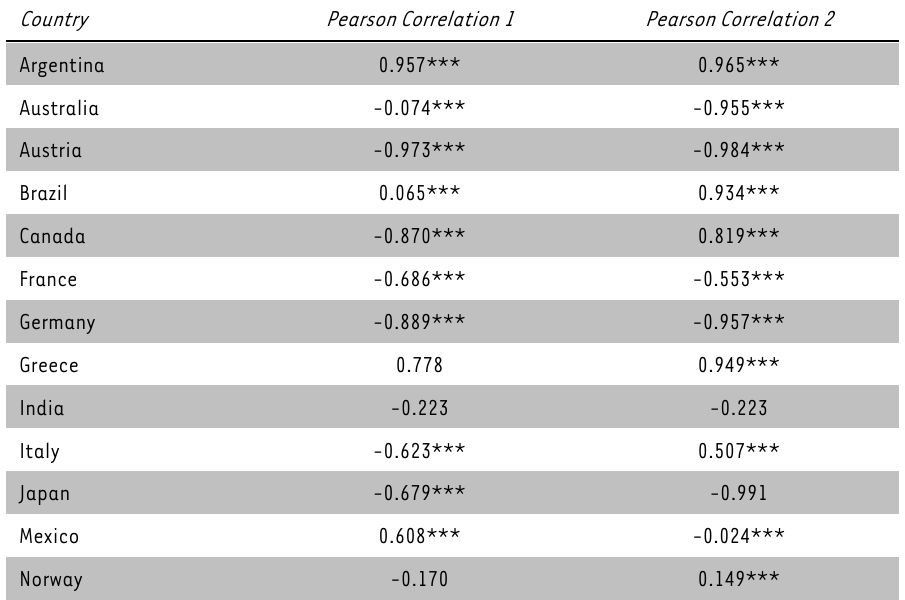
TABLE 8: Pearson correlation results of EMP and EOP